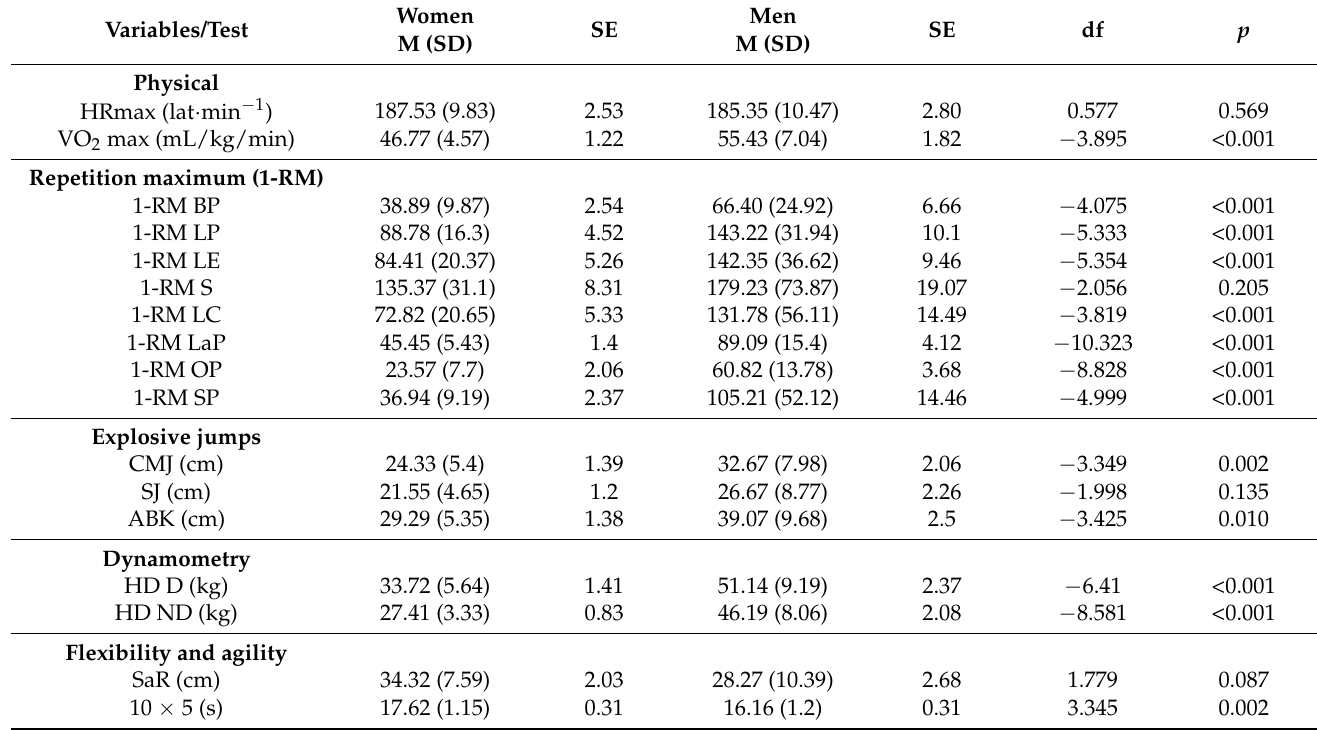
Table 2. Differences in physical test by gender.